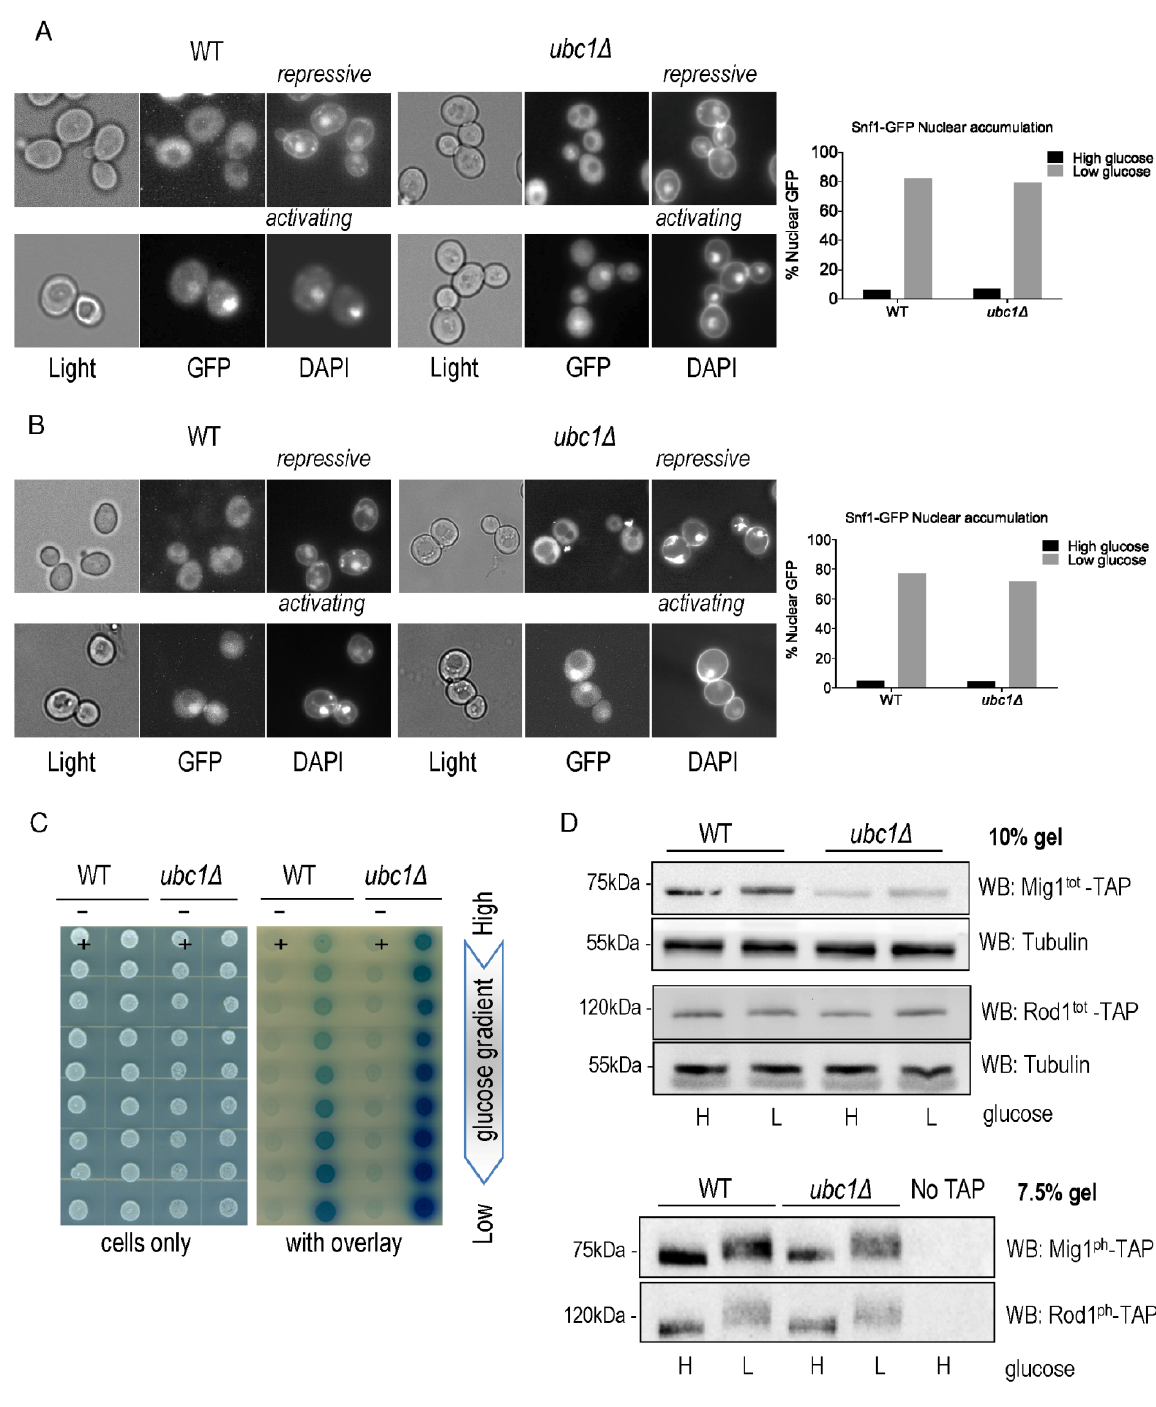
FIGURE 2: Loss of Ubc1 function does not impair SNF1 kinase nuclear accumulation, allosteric associations or substrate targeting. (A) Fluorescent microscopy of GFP-tagged yeast Snf1 constitutively expressed from a high copy 2μ plasmid or (B) expressed from the endoge- nous Snf1 promoter in isogenic WT and ubc1 Δ strains grown under repressive (2% glucose) or shifted to activating (5% glycerol for 30 minutes) conditions. The percent of cells with Snf1-GFP nuclear accumulation was quantitated from four biological repeats. 125 consecutive cells were scored for co-localization of GFP and DAPI signal in high and low glucose in the isogenic WT and ubc1 Δ strains. (C) 2-hybrid asso- ciations between empty vectors (-) and Snf1-Snf4 pairs (+) in WT and ubc1 Δ strains are shown. Equal cell numbers were spotted down a glucose gradient (0.05% to 2% glucose) before and after β-galactosidase color development from overlay. (D) Isogenic WT and ubc1 Δ strains harboring endogenous TAP-epitope tags to Mig1 and Rod1 were divided into high (H: 2%) and low (L: 0.05%) glucose media for 30 minutes prior to cell lysis. Duplicate sample were run in parallel on 10% acrylamide gels (for total TAP-protein; Mig1 tot and Rod1 tot , upper panels) and 7.5% (to enhance the phospho-shift; Mig1 ph and Rod1 ph , lower panels). WB: Western Blot primary antibody/target. Light: non fluores- cent 100 x objective. GFP: green fluorescent protein epitope tag. DAPI: (4',6-Diamidino-2-Phenylindole, Dihydrochloride) a fluorescent DNA